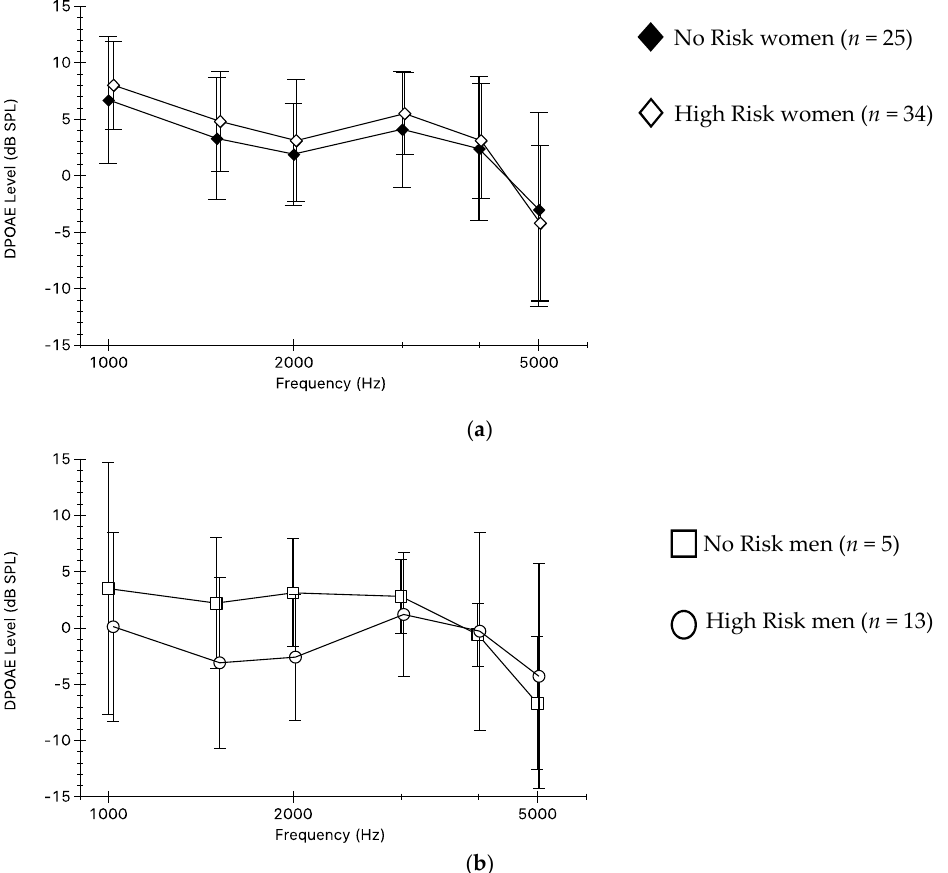
Figure 6. ( a ) The means and standard deviations are shown for DPOAE levels across the frequencies tested in women only by Risk categories.; ( b ) The means and standard deviations are shown for DPOAE levels across the frequencies tested in men only by Risk categories.